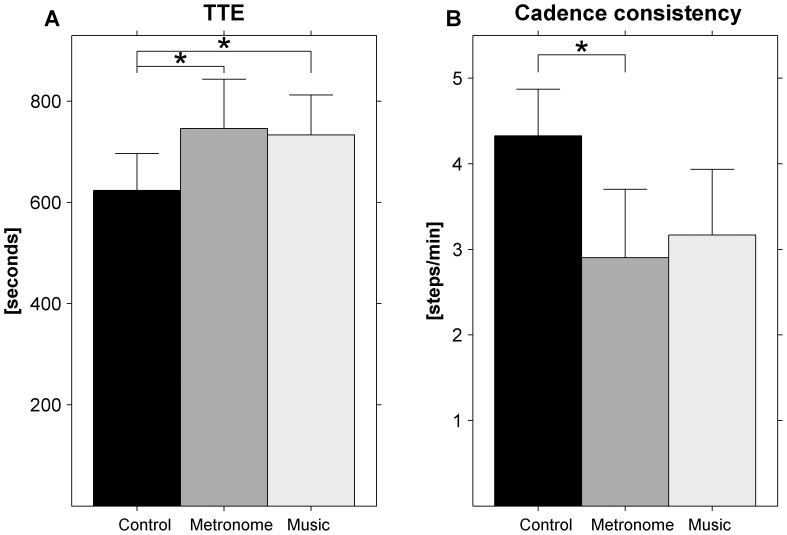
TTE in seconds (A) and cadence consistency in steps/min (B) data of the exhaustion phase for control (black), metronome (dark gray), and motivational music (light gray) conditions.Error bars represent the standard error while asterisks indicate significant differences across conditions.